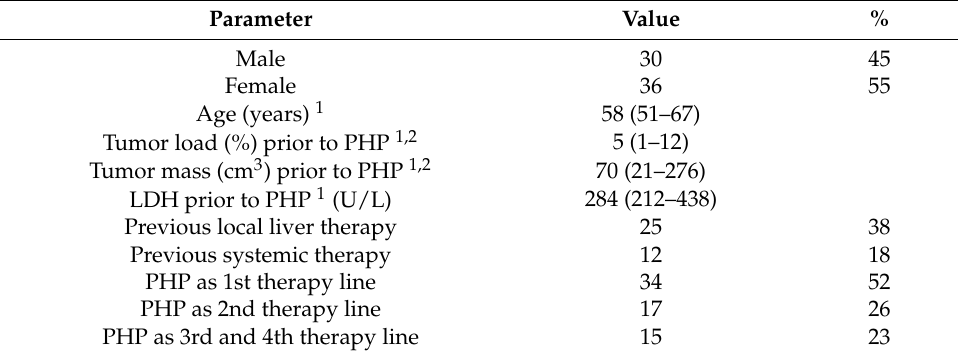
Table 1. Patient demographics and clinical characteristics of all patients ( n = 66) treated with percutaneous hepatic perfusion (PHP).